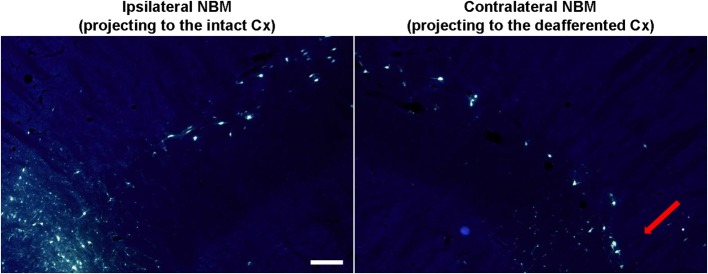
Retrogradely labeled MBN neurons after fluoro-gold (FG) injections in the barrel cortex. Fluorescent micrographs (UV filter) showing cell bodies in MBN that have been retrogradely labeled after bilateral-FG injection in the ipsilateral (non-affected, left) and the contralateral (deafferented, right) barrel cortex. MBN-cortical projecting neurons are diffusely scattered through MBN but they are mainly located in the caudal zone (somatosensory area, red arrow). Deafferentation results in a global neuronal damage being more intense in the specific somatosensory MBN area. In the ipsilateral hemisphere lateral is left; in the contralateral hemisphere lateral is right; rostral is top. Scale bar = 200 μm.